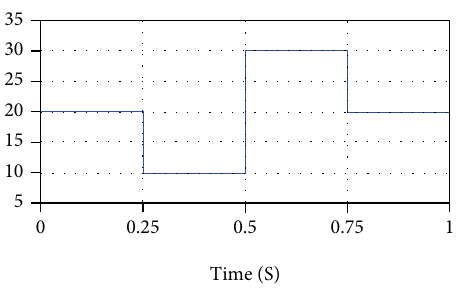
Figure 7: Load resistor changes.